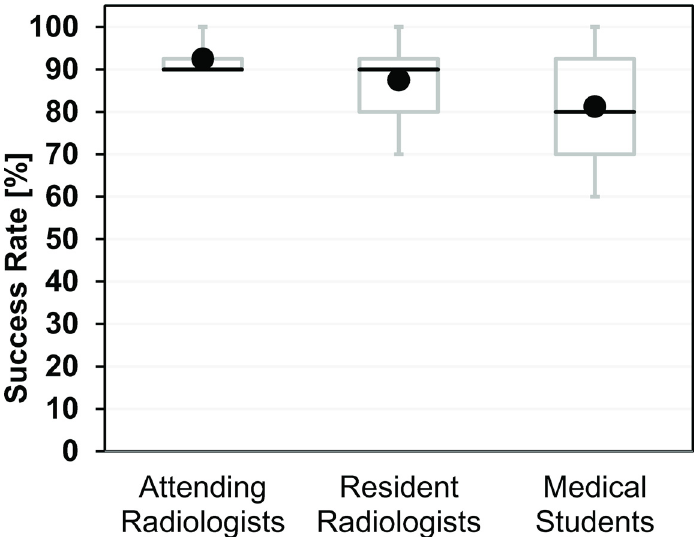
Fig 4. Success rates of experimental biopsies performed by 24 operators from three different groups (AR, RR, MS). Each operator performed 10 trials and the individual success rate was simply the number of successful biopsies multiplied by 10%. Each box with whiskers represents the summary for 8 operators in each group. The gray box stretches from the first (25%, Q1) to the third (75%, Q3) quartile and the black line indicates the second (50%, Q2) quartile (median). Owing to the low number of operators per group (n = 8), the whiskers correspond to the minimum and maximum success rates observed for a single operator. The black circles indicate the mean success rates. Please note that minimum, Q1, and Q2 of the success rate coincide at 90% for the group of attending radiologists. Between-group differences in the mean success rate were statistically not significant (p =